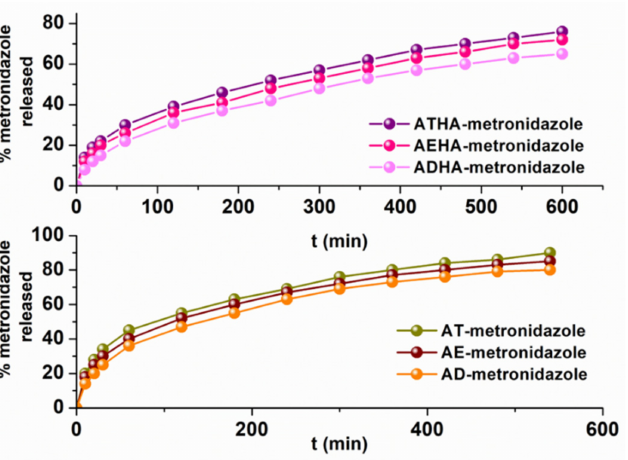
Figure 15. Metronidazole release profiles from precursor/hybrid microparticles (pH =